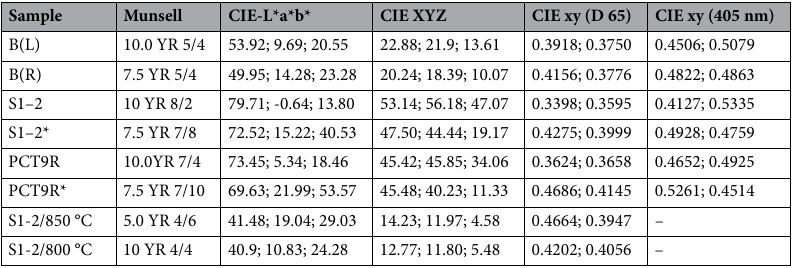
Table 4. Munsell colorimetry obtained as reflections of the day light equivalent illumination (D 65) compared with blue light